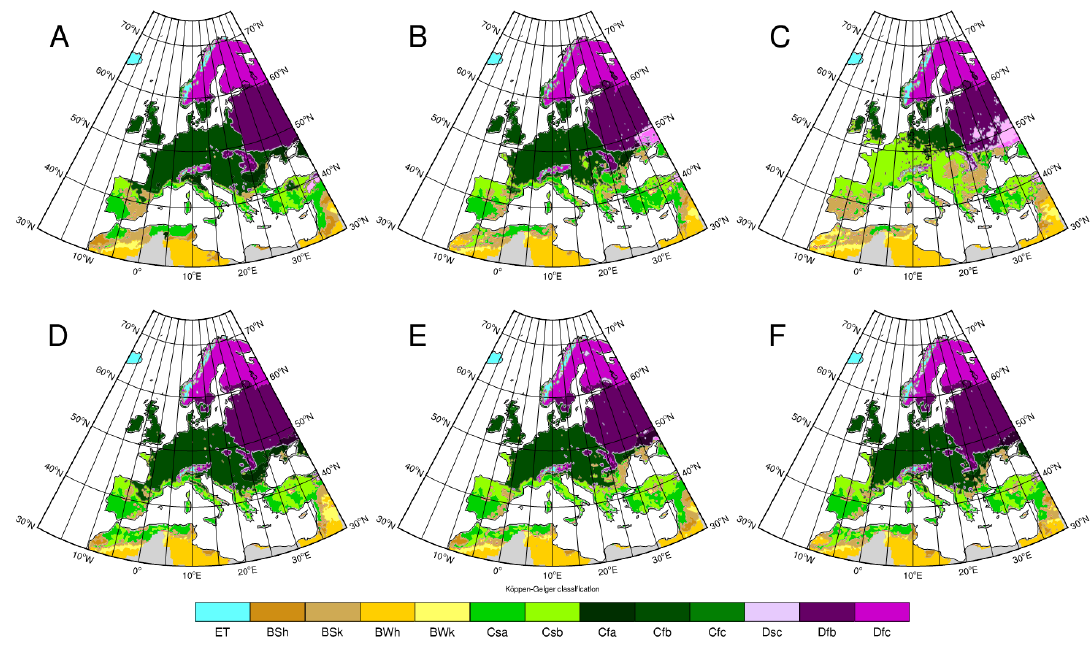
Figure 8. Simulated K-G climate classification according to E-OBS ( A ) and gpQM corrected precipitation and eQM corrected temperature with a 90-day moving window in ALADIN ( B ), HIRHAM ( C ), RegCM ( D ), RAMCMO2 ( E ) and RCA ( F ) in the test period in 1981 − 2000.